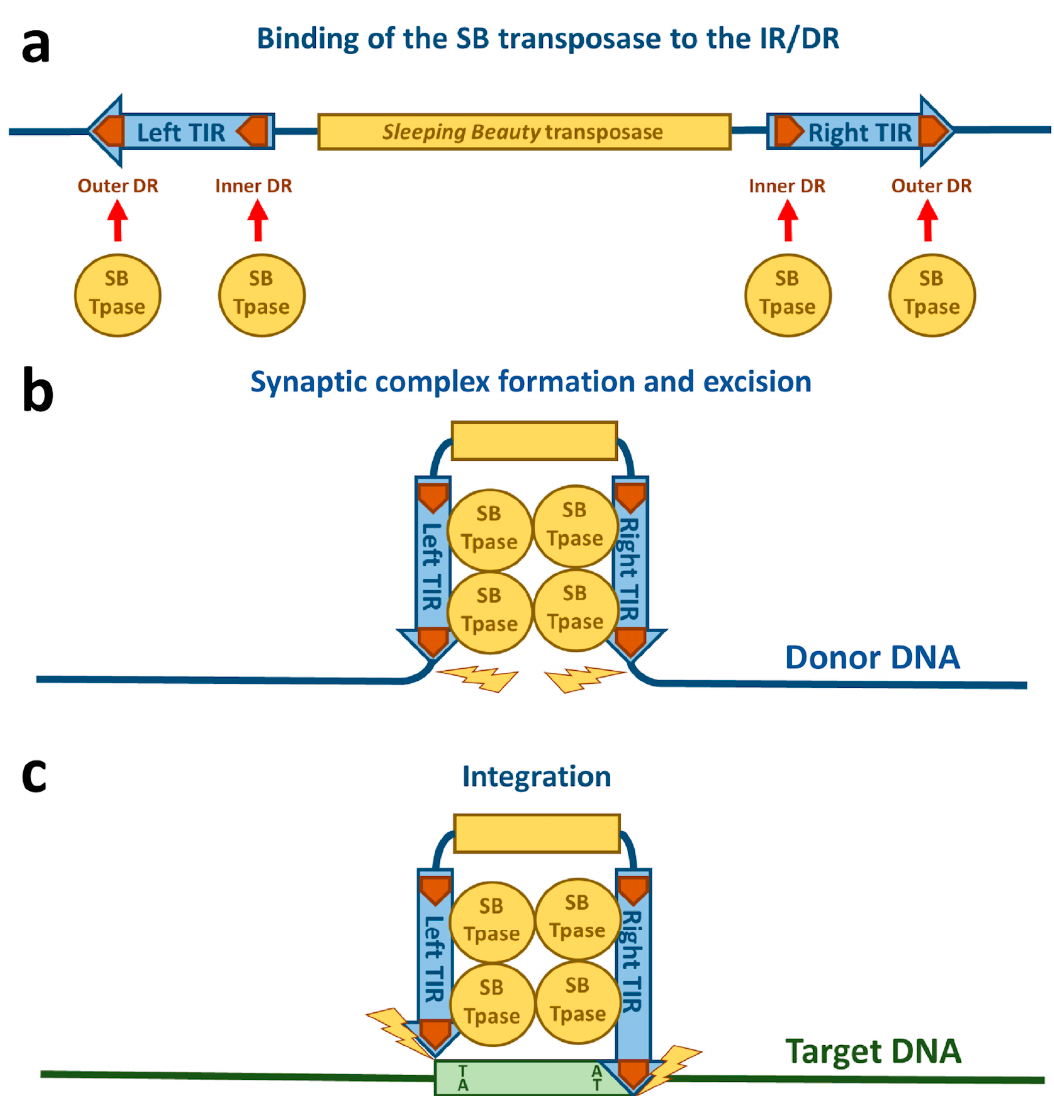
Figure 2. Schematic drawing of Sleeping Beauty transposition. ( a ) The SB transposase (blue circle) binds to the DRs (orange arrows) within the TIRs. ( b ) The TIRs are brought together by SB transposase molecules in a synaptic complex. Excision of the SB transposon takes place from the donor DNA indicated by yellow flashes. ( c ) The excised transposon integrates into a TA site in the target DNA (green box) that is afterwards duplicated and flanks the new target